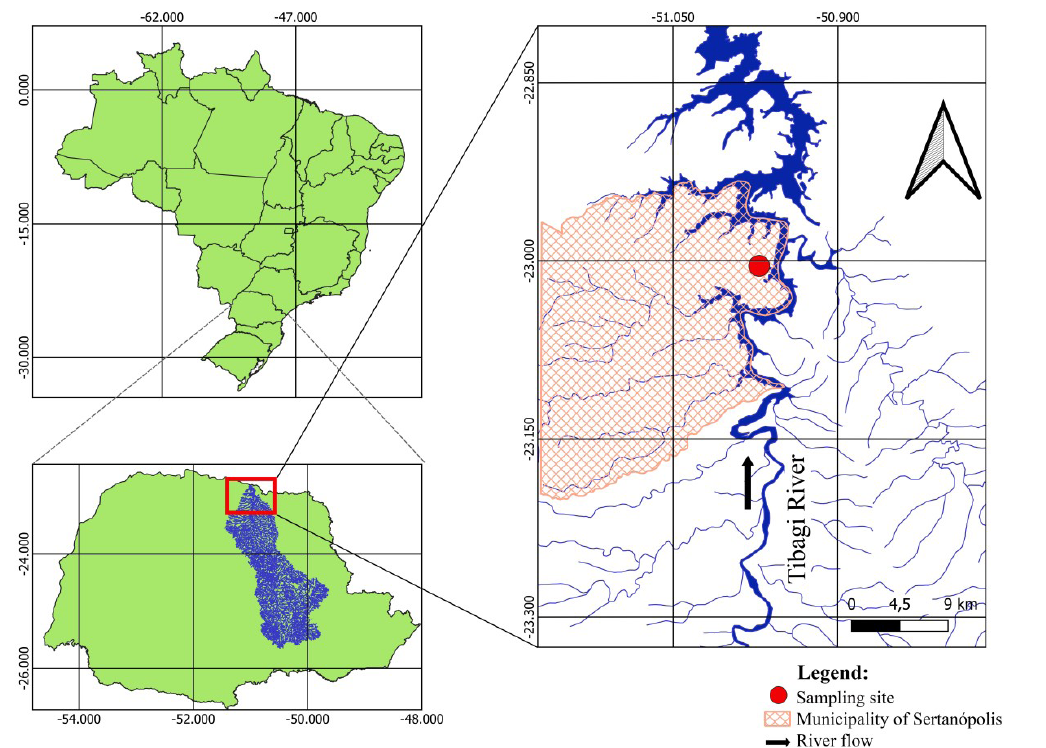
Figure 1. Map of the Tibagi River, Upper Paraná River Basin, Municipality of Sertanópolis – PR, indicating the location of the marginal lagoon